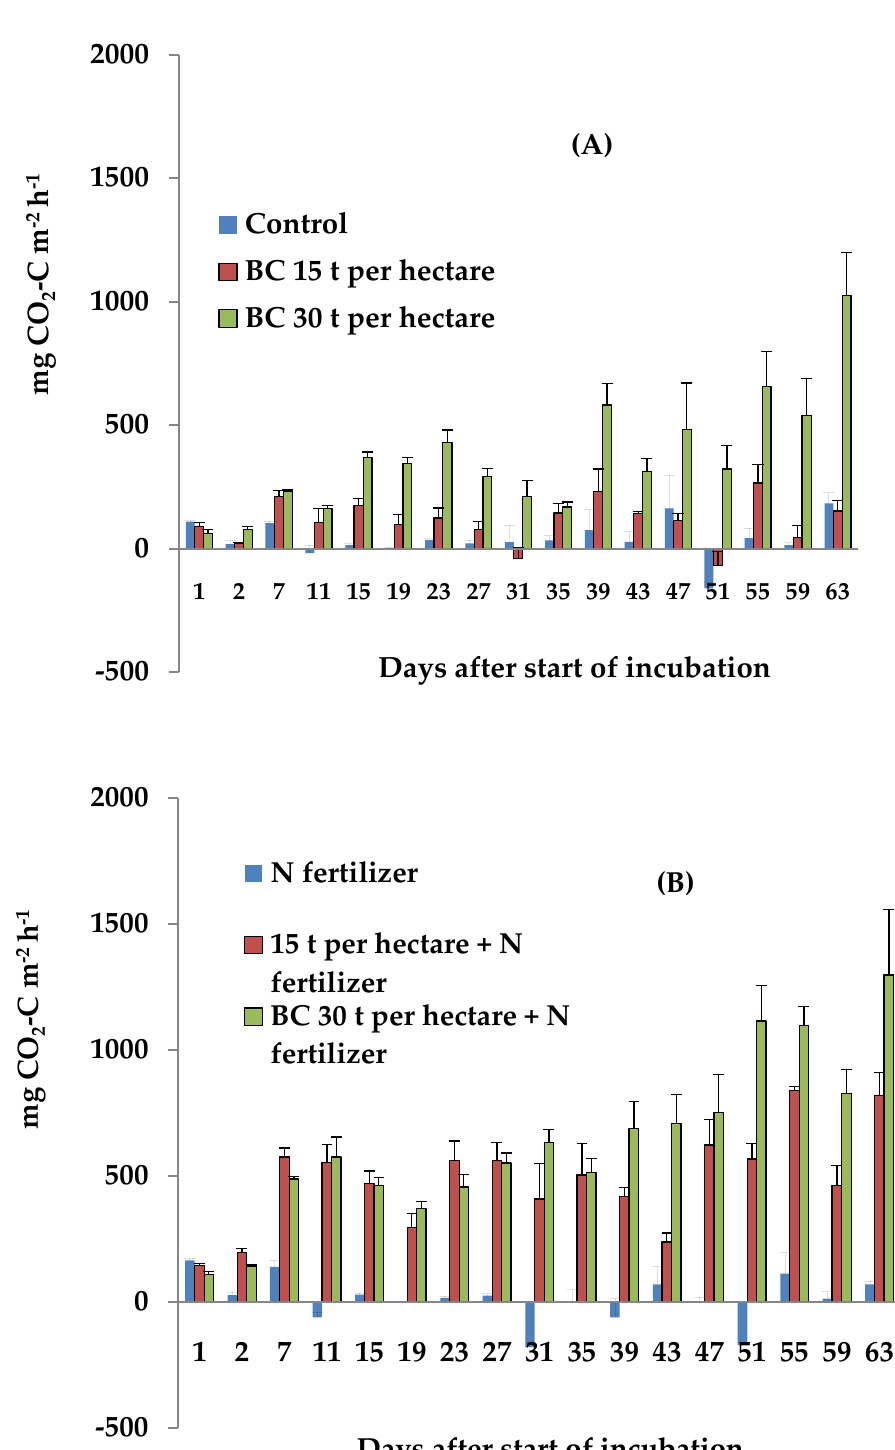
Figure 1. Dynamics of daily CO 2 emissions from the sandy soil with ( A ) no N fertilizer and ( B ) with N-fertilizer, during the incubation period. Error bars show the standard error of the mean for each treatment ( n = 6).